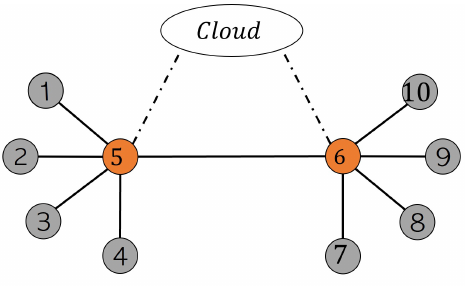
Figure 7. Undirected graph of communication between edge devices and fog servers for asynchronous FL, edge devices 5 and 6 play the fog